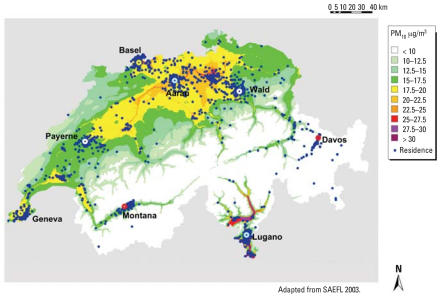
Dispersion modeling predictions for PM10 concentrations outside residences of the SAPALDIA 2 cohort.